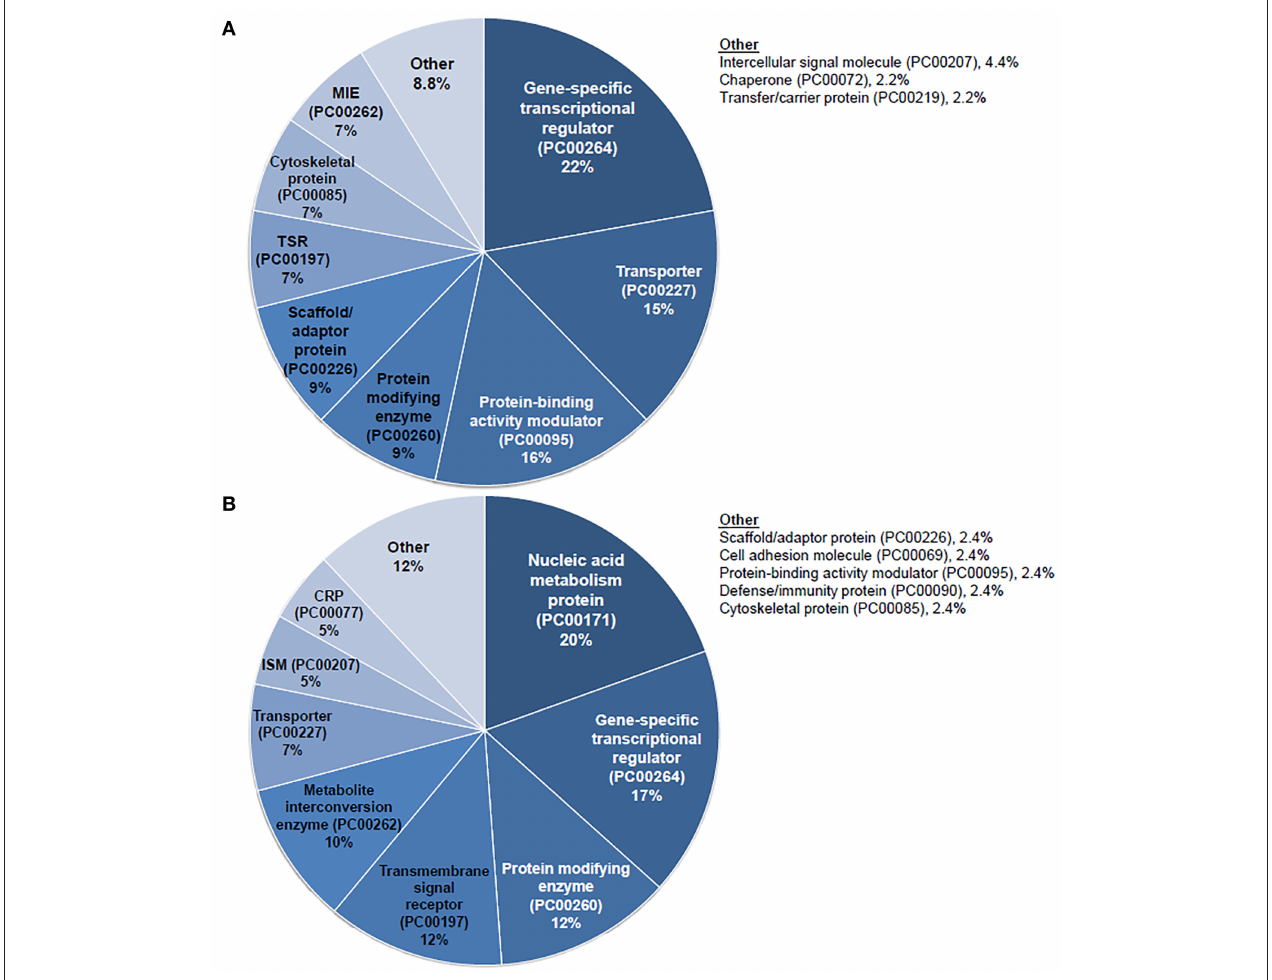
FIGURE 5 | PANTHER protein class analysis of steroid responsive gene expression in the adult mouse spiral ganglion neurons after treatment with transtympanic vs. systemic steroids. Panther protein classification of 70 upregulated (A) and downregulated (B) differentially expressed genes (DEGs) in adult mouse spiral ganglion neurons (SGN) exposed to transtympanic steroids (TTS) compared to systemic steroids (SS). Percentages refer to the proportion of DEGs classified to each protein class. MIE, metabolite interconversion enzyme; TSR, transmembrane signal receptor; CRP, chromatin/chromatin-binding or -regulatory protein; ISM, intercellular signal